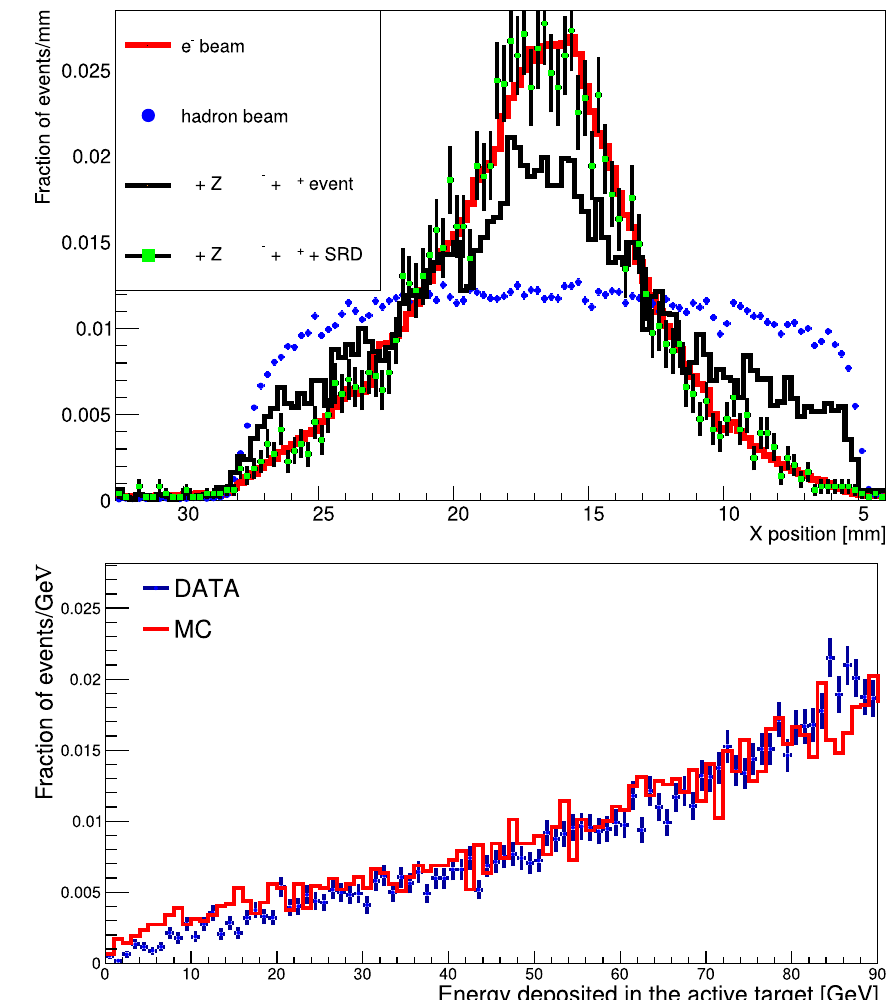
Fig. 7 Energy deposit in the active dump (WCAL) after all selection criteria are applied in e − Z → e − Z γ( → μ + μ − ) event for data collected in 2018 (blue dots) and MC-generated events (red